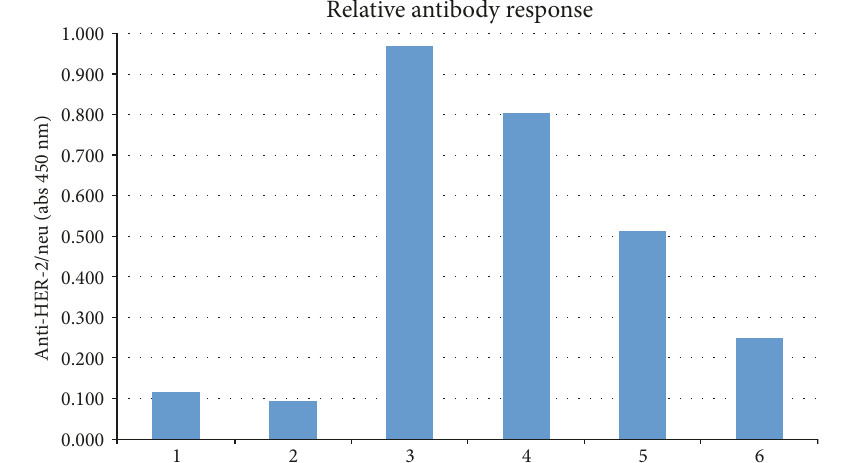
Figure 3: Anti-HER-2/neu antibody levels. Serum obtained from mice from the experiment shown in Figure 1 on day 7 after tumor challenge (collected on day 28 after the fi rst vaccination) was evaluated by ELISA at two serum dilutions for antibody to HER-2/neu. Mice that were unimmunized and unchallenged provided the control serum ( “ nontumor ” ). Nontumor: 1 (1 :10), 2 (1 :100); tumor only: 3 (1 :10), 4 (1 :100); tumor+vaccine: 5 (1 :10), 6 (1